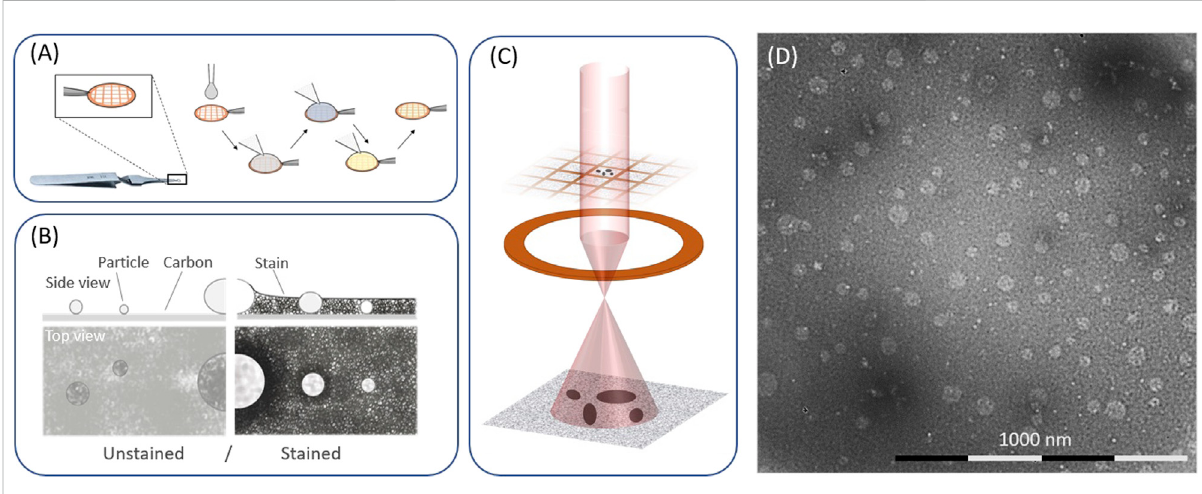
TEM work fl ow. (A) Depiction of an EM grid, used as support, and representative steps of a specimen preparation with specimen deposition (1), washing (2, 3), staining (4) and drying (5). (B) Schematic representations of an unstained and stain specimen. (C) image formation in an electron microscope. (D) representative image of a VLP prepared and imaged by negative stain